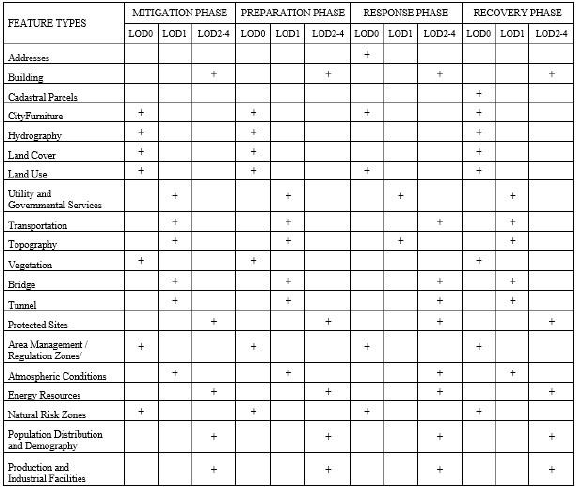
Table 2. Geo-information requirement analysis for the